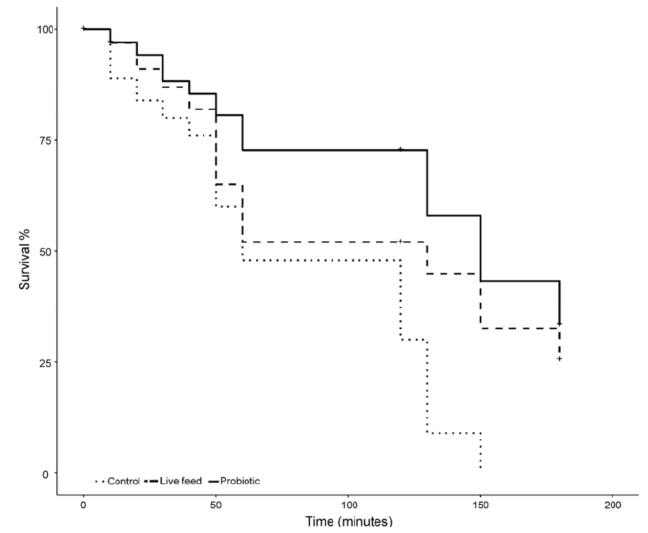
Figure 5. Salinity stress test mortality over a 3 h time frame ( n = 100), after 21 dph.